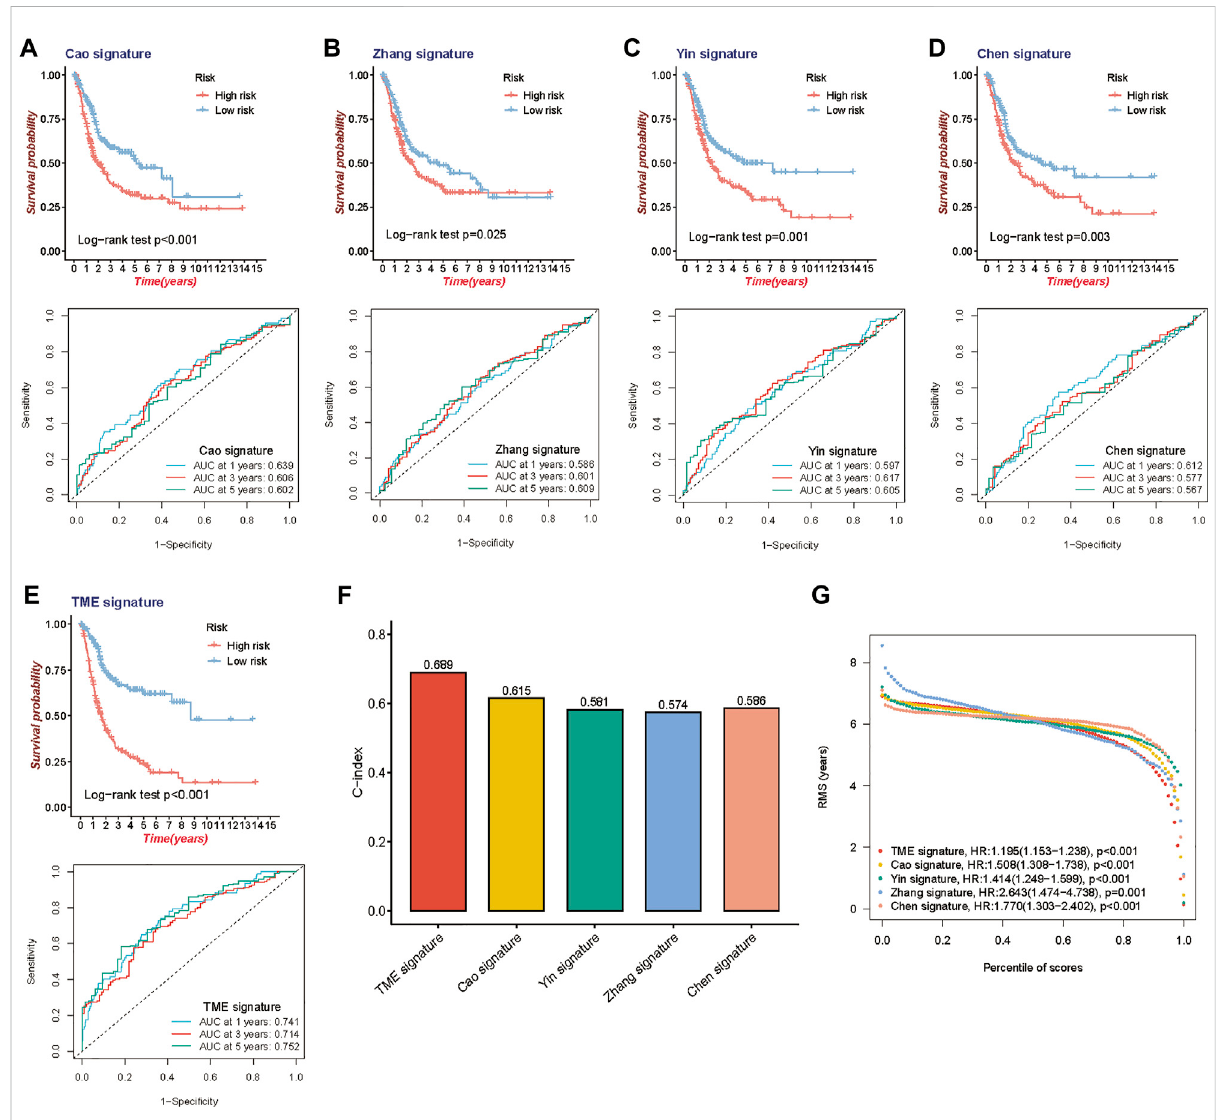
FIGURE 4 Comparison of the 10-gene risk model with other established models. (A – E) Kaplan-Meier survival curves and ROC curve of TME gene signaturewithfourotherpublishedgenesignatures. (F) Concordanceindex(C-index)ofthe fi veprognosticriskmodels. (G) Restrictedmeansurvival (RMS) time curve of the fi ve prognostic risk